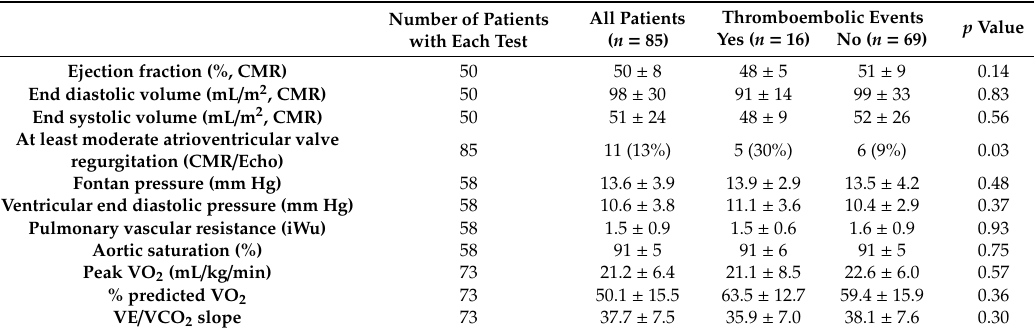
Table 2. Hemodynamic and cardiac imaging results. All Patients Number of Patients ( n = with Each Test